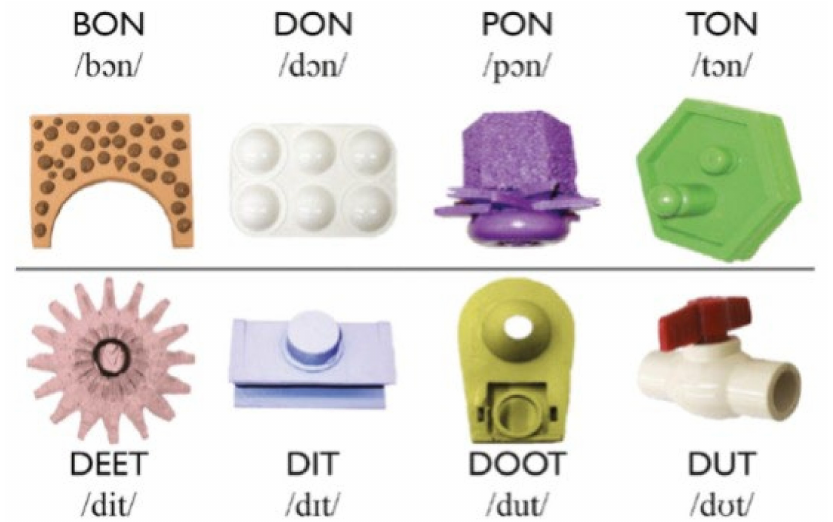
Figure 1. The eight pseudo words and their visual referents. The four words in the top row are minimally different in their initial consonant, whereas the words on the bottom are minimally different in their vowel. The vowel used for the consonant minimal pairs is / O / as in POT. Vowels used for the vowel minimal pairs are /i/ as in BEAT, / I / as in BIT, /u/ as in BOOT, and / U / as in PUT. Figure 1 originates from